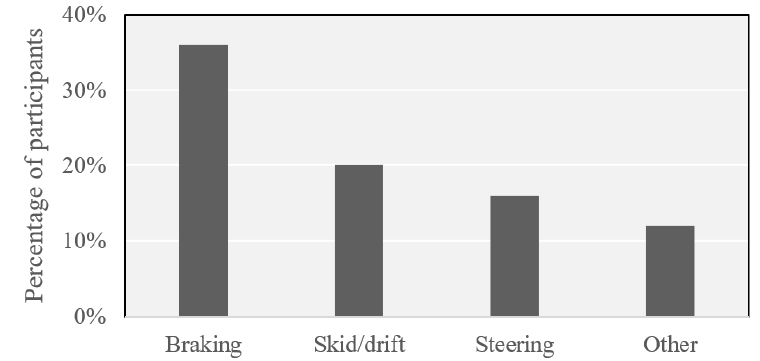
Figure 11. Topical areas for skills used to avoid a crash: phone interview.